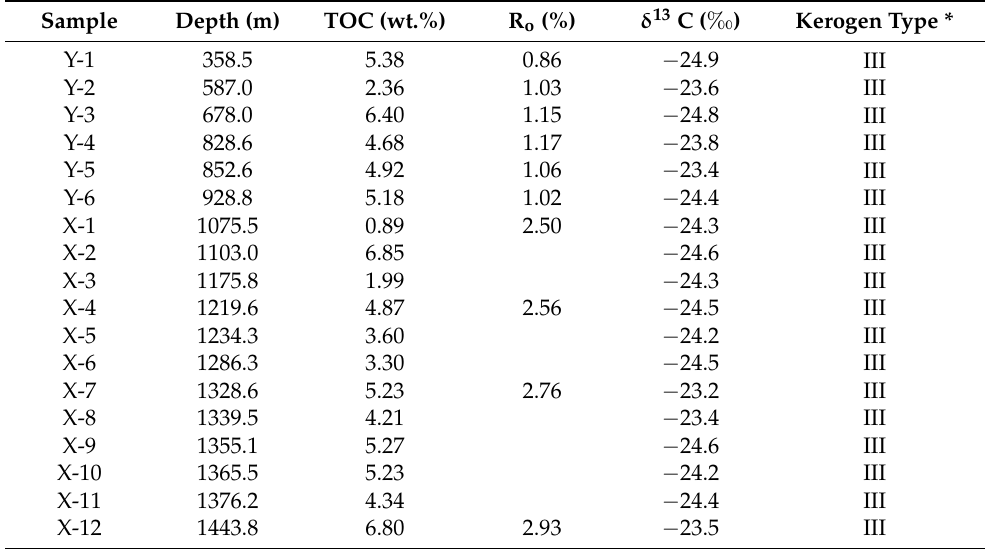
Table 2. Organic geochemical test results of transitional Longtan Shale samples from YV-1 and